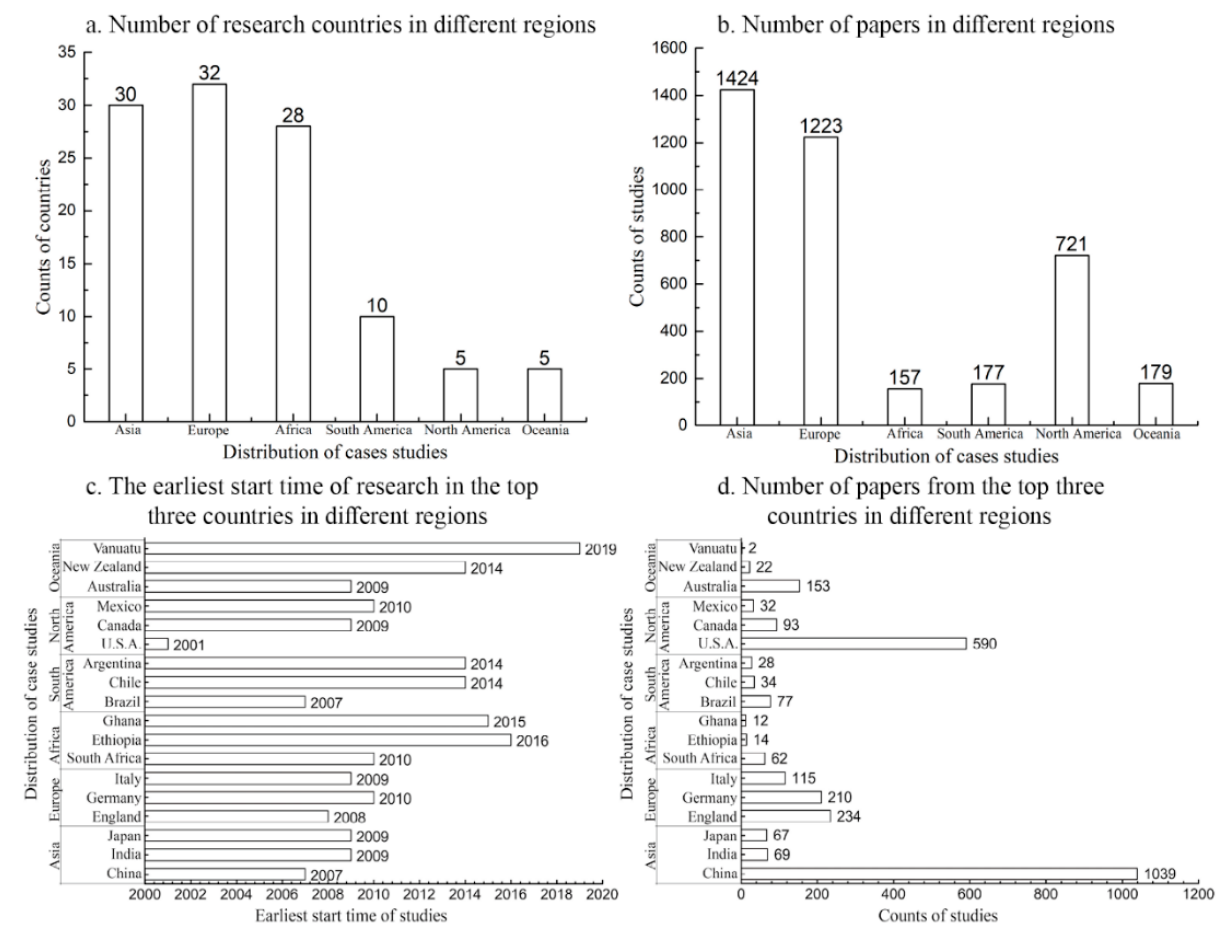
Figure 2. Study areas and paper distribution.